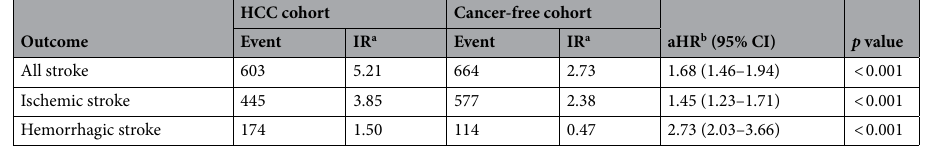
aHR b (95% CI) p valueEvent IR a Event IR a